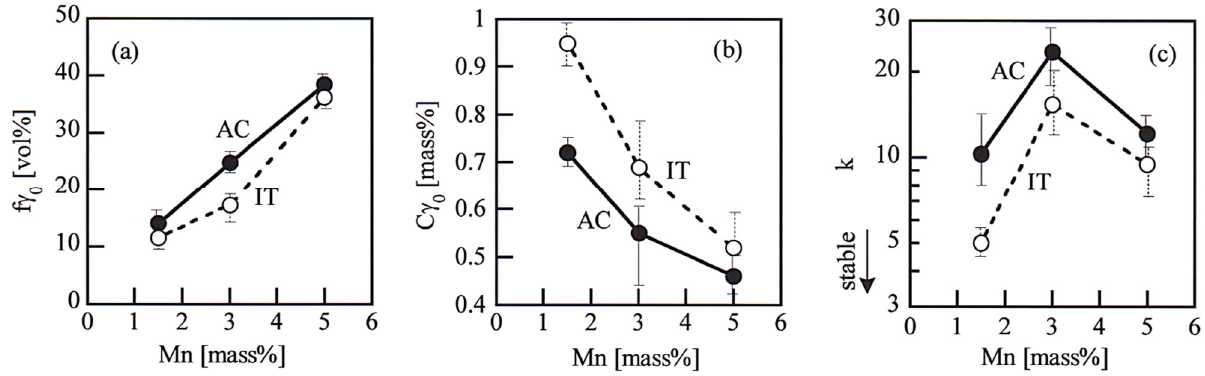
Figure 4. Variations in ( a ) initial volume fraction ( f γ 0 ), ( b ) initial carbon concentration ( C γ 0 ), and ( c ) strain-induced transformation factor ( k ) of reverted austenite as a function of Mn content in the steels subjected to the AC ( ● ) and IT ( ○ ) processes after intercritical annealing.